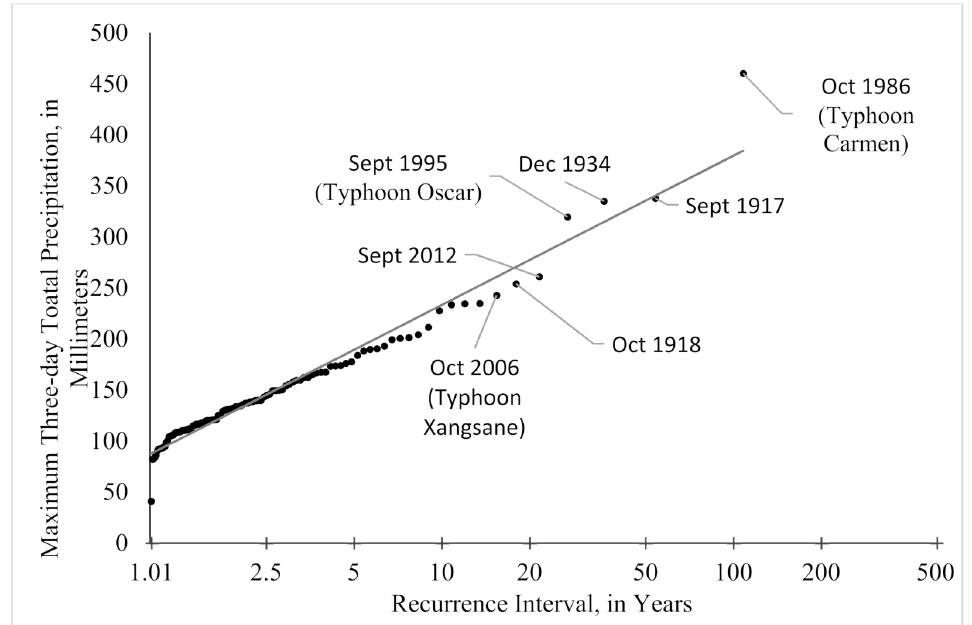
Figure 6. Recurrence interval of the maximum precipitation that occurred for each year in Seward. Some storms will have moderate rainfall but will stall over the region. To account for these types of events, the recurrence interval of severe rainfall events is estimated by summing three days of precipitation values. Computed from daily records, 1908–1925 and 1929–2018, measured in